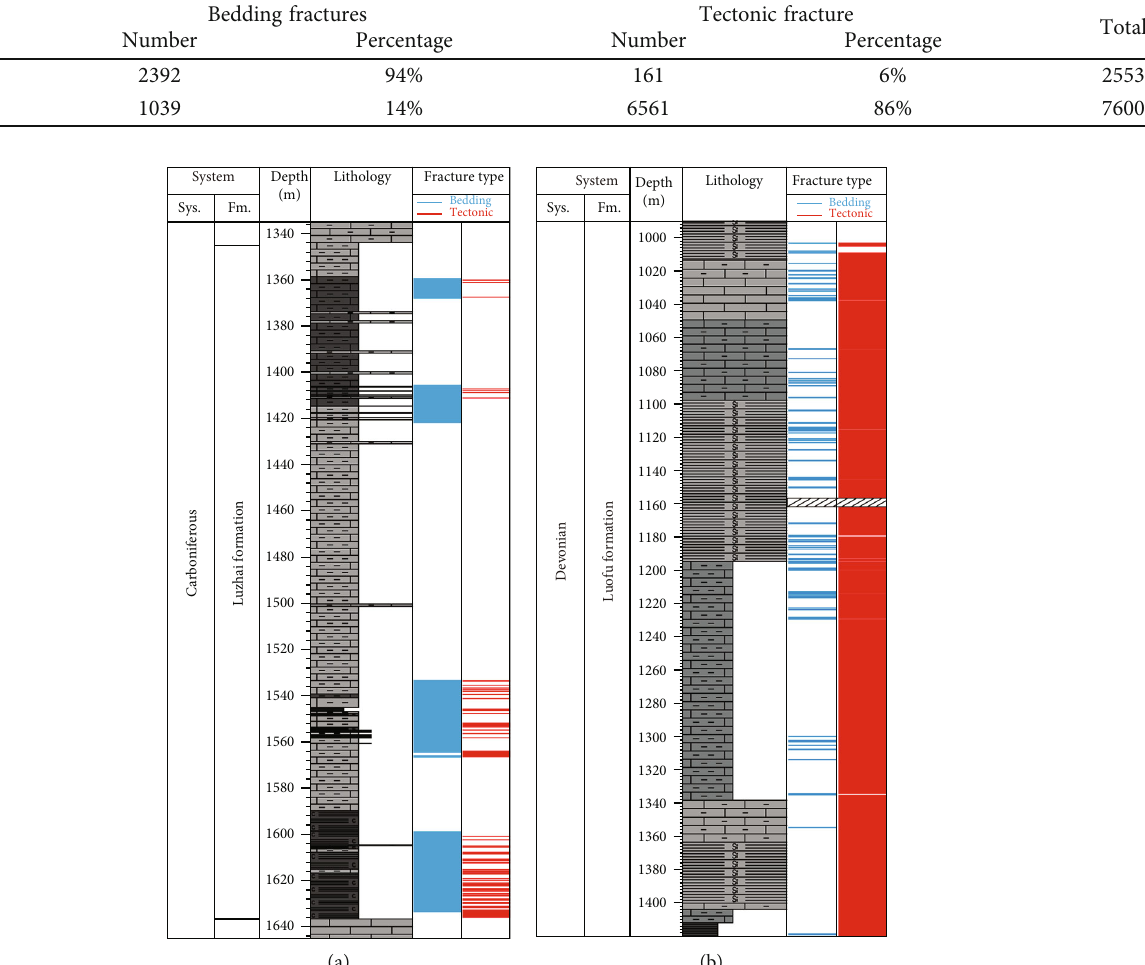
Figure 15: (a) Statistical results of fracture type and development in Carboniferous shale (well GRY1); (b) statistical results of fracture type and development in Devonian shale (well